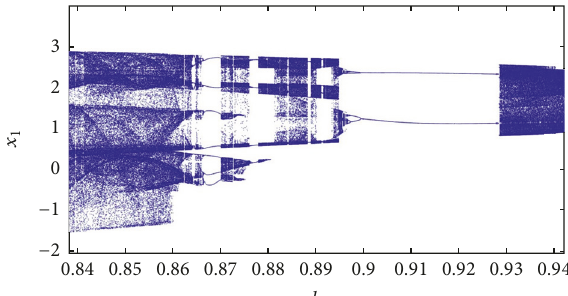
Figure 23: Bifurcation diagram of two coupled neurons for different memristor-type coupling intensities ( 𝑘 = 0.84 to 𝑘 = 0.94 ), while 𝐷 = 1 and other parameters are at their nominal